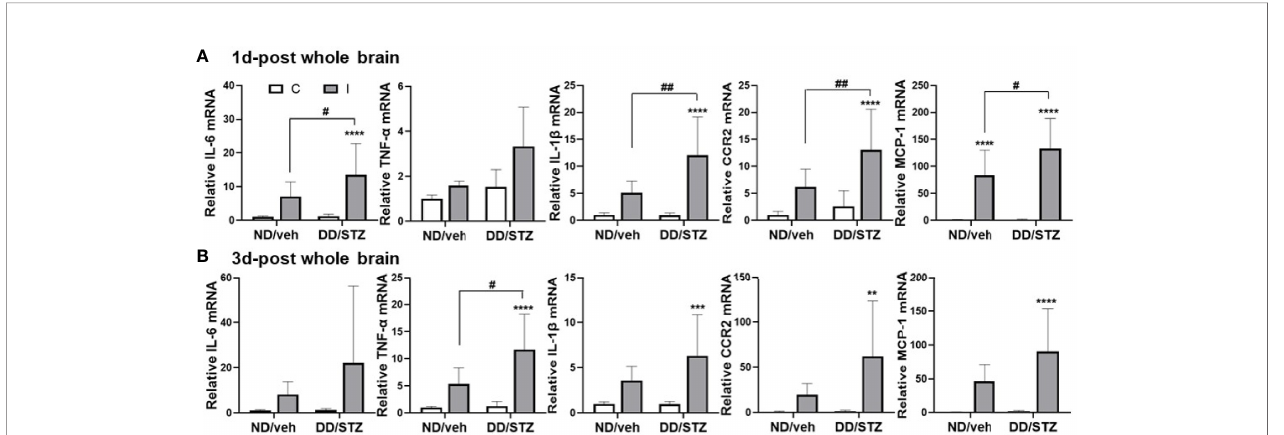
value of contralateral side of ND/veh at pre was regarded as 1, and we calculated the relative values for the others. n = 7 – 10/group (1d-post, 10 for ND/veh, 10 for DD/STZ; 3d-post, 7 for ND/veh, 10 for DD/STZ). Data are presented as means ± SD; ** p < 0.01, *** p < 0.001, **** p < 0.0001 vs. ND/Veh, # p < 0.05, ## p < 0.01, vs. 1 days post- stroke. Two-way ANOVA and Bonferroni test; ND/veh, mice fed normal chow and injected vehicle; DD/STZ, mice fed HFD and injected STZ; C, contralateral; I,